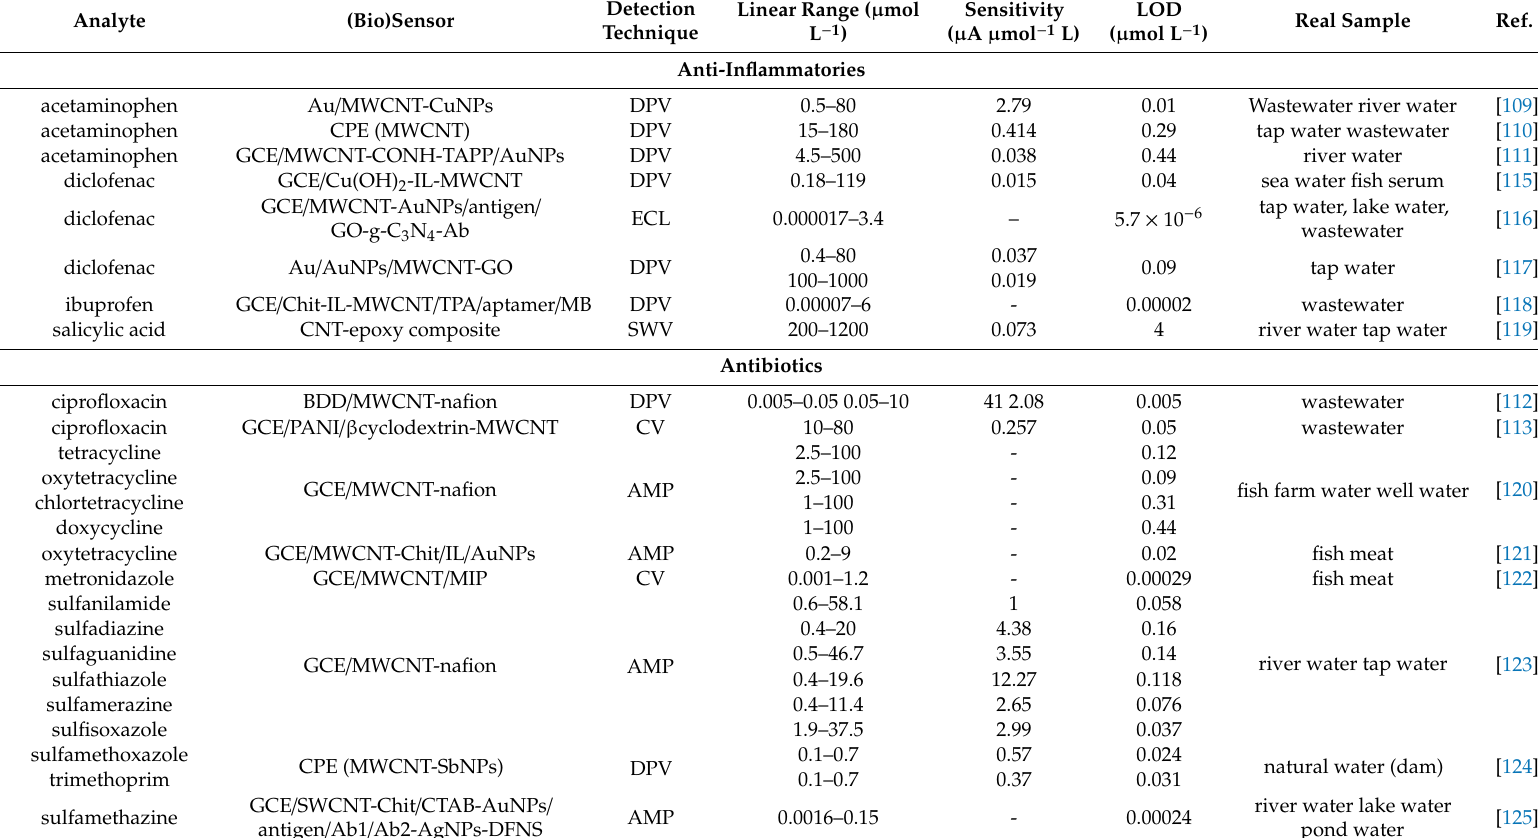
Table 2. Carbon nanotubes-based electrochemical (bio)sensors for emerging pharmaceutical pollutants in aquatic species and environmental samples.